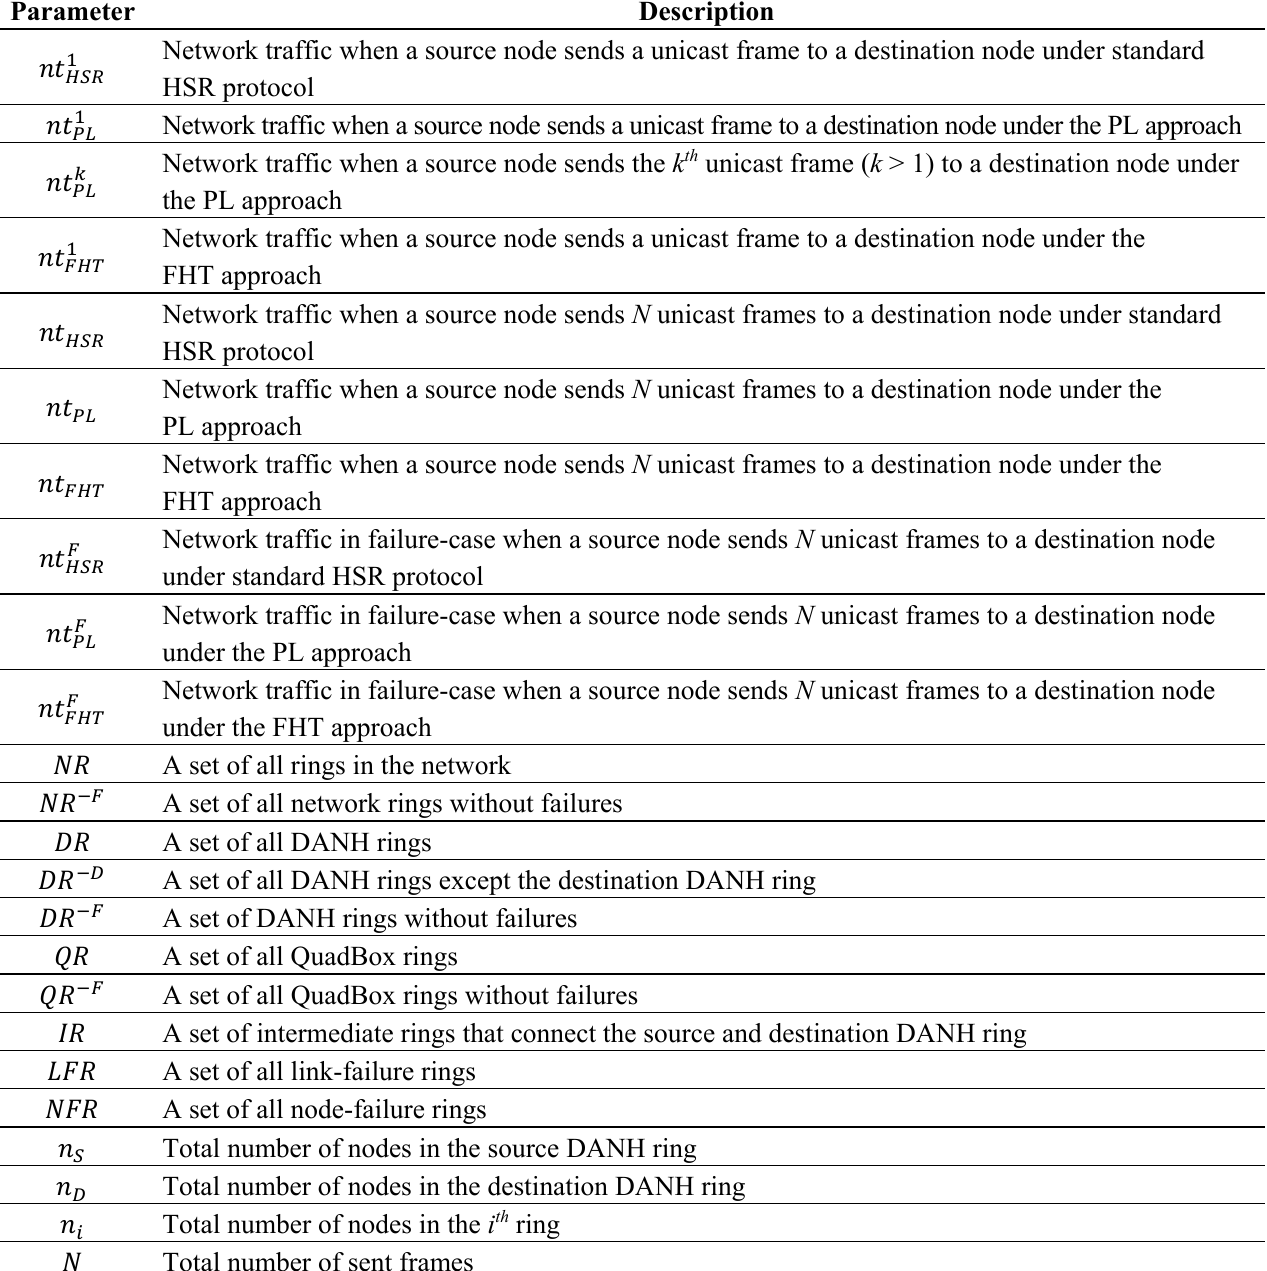
Table 1. Parameters for network traffic performance analysis. Parameter